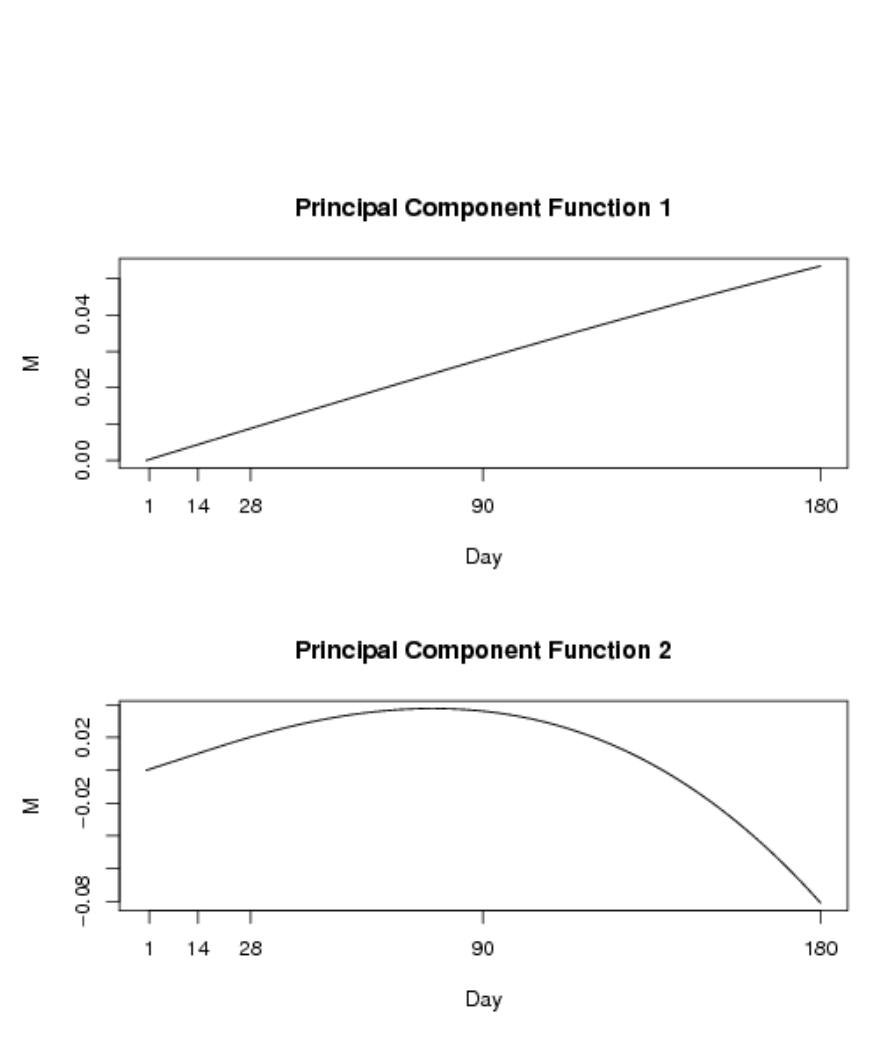
Figure 6 – Two principal component functions which explain 99.9% of the variation observed in the fitted mean curves for each gene. The first principal component describes a linear relationship with time. The second principal component captures a more quadratic